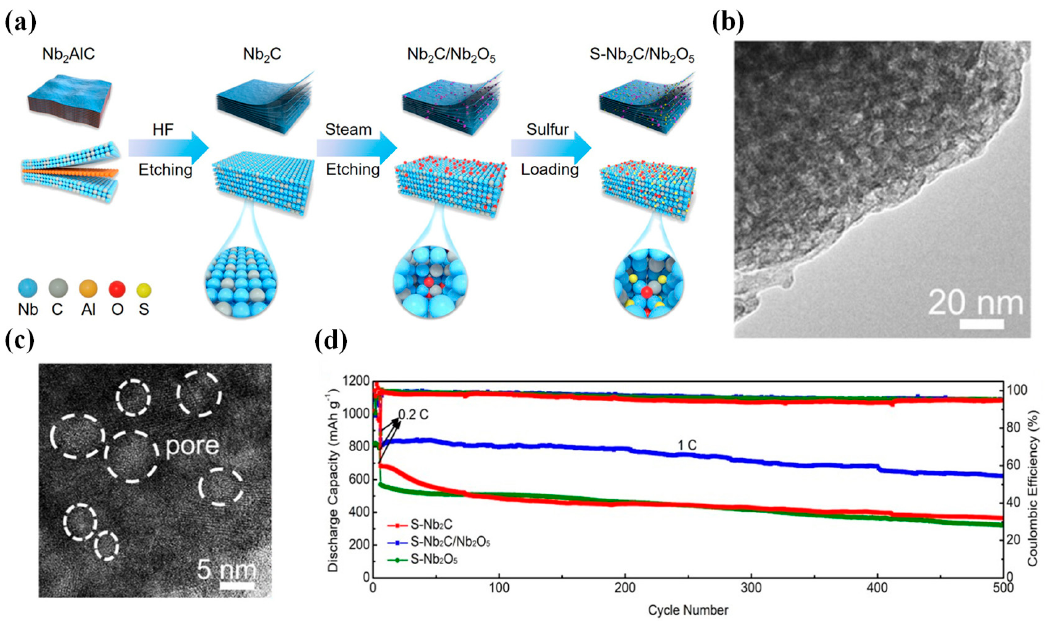
Figure 8. Applications of Nb 2 CT x in LSBs. ( a ) Schematics of preparation of S-Nb 2 C/Nb 2 O 5 heterostructures, ( b , c ) TEM images of Nb 2 C/Nb 2 O 5 , ( d ) Cycling stability of S-Nb 2 C/Nb 2 O 5 electrodes at 1.0 C. [100] Copyright Elsevier, 2022.